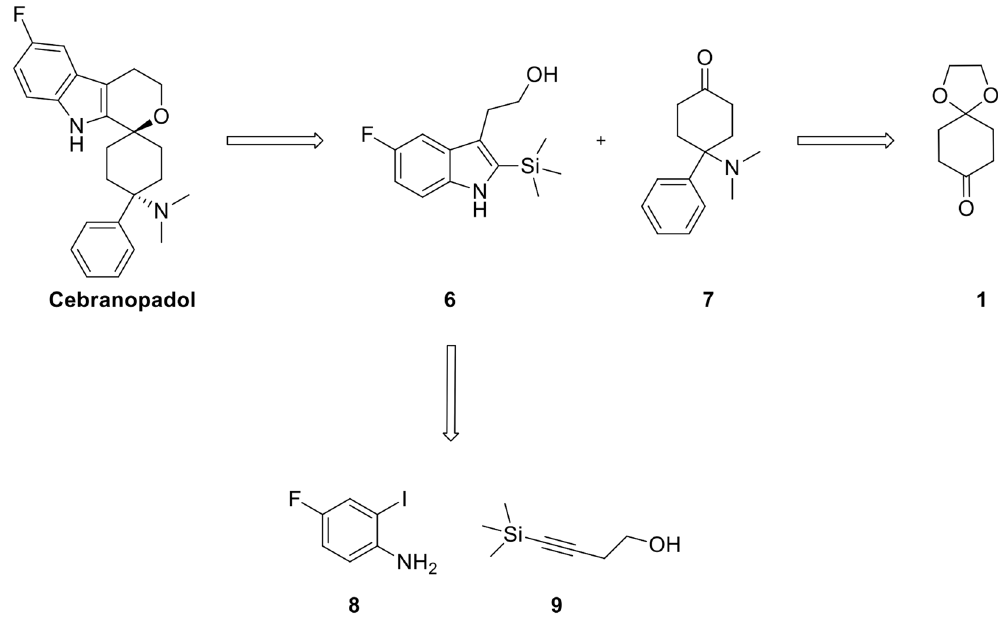
Figure 2. Retrosynthesis of